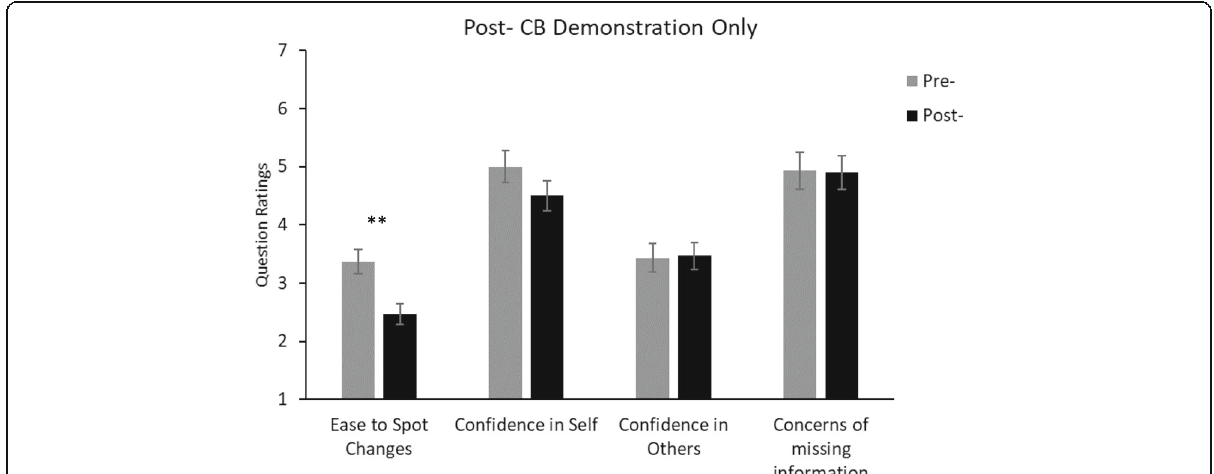
Fig. 4 Average ratings from the post-demonstration data of the post-test only condition in Experiment 2. The pre-questionnaire data were taken from the replication condition for statistical comparison. For the “ ease to spot changes ” question, the rating scale ranged from 1 (very difficult) to 5 (very easy). For the other questions, the rating scales ranged from 1 (not at all confident/concerned) to 7 (totally confident/concerned).